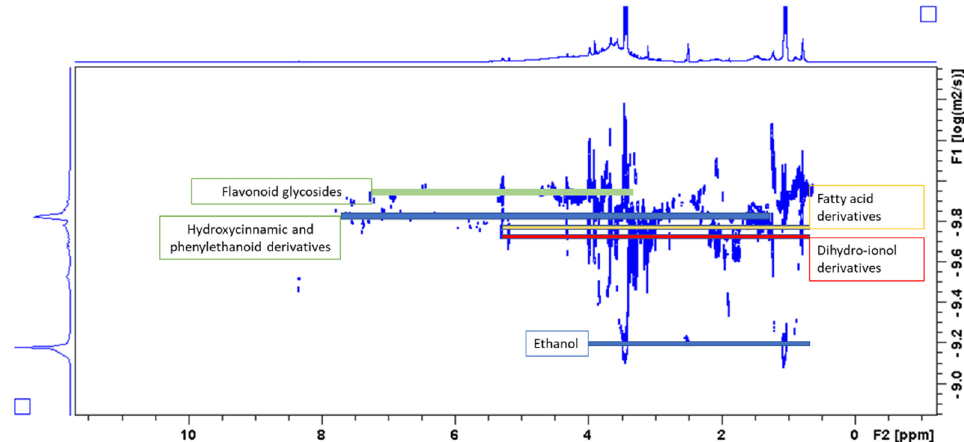
Figure 3. Diffusion order spectroscopy (DOSY) spectrum showing some of the different classes of constituents present in the C. hirtus extract. Table 2. Identification and quantification of compounds in methanolic extract of Croton hirtus. * compared with authentic